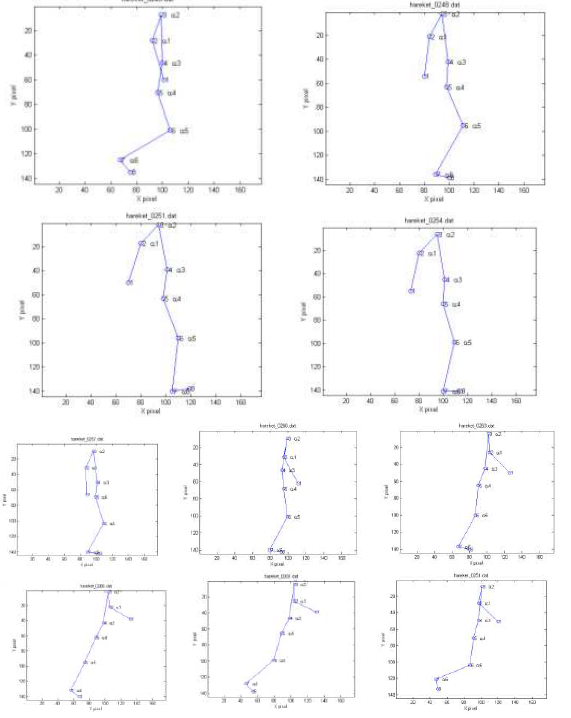
Figure 8). The variations on the angles during the motion are shown on Figure 9.